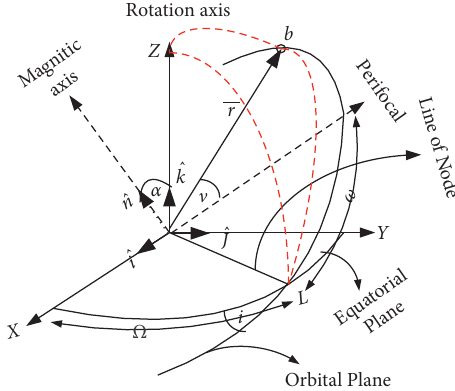
Figure 2: Orbital motion in planet dipole magnetic